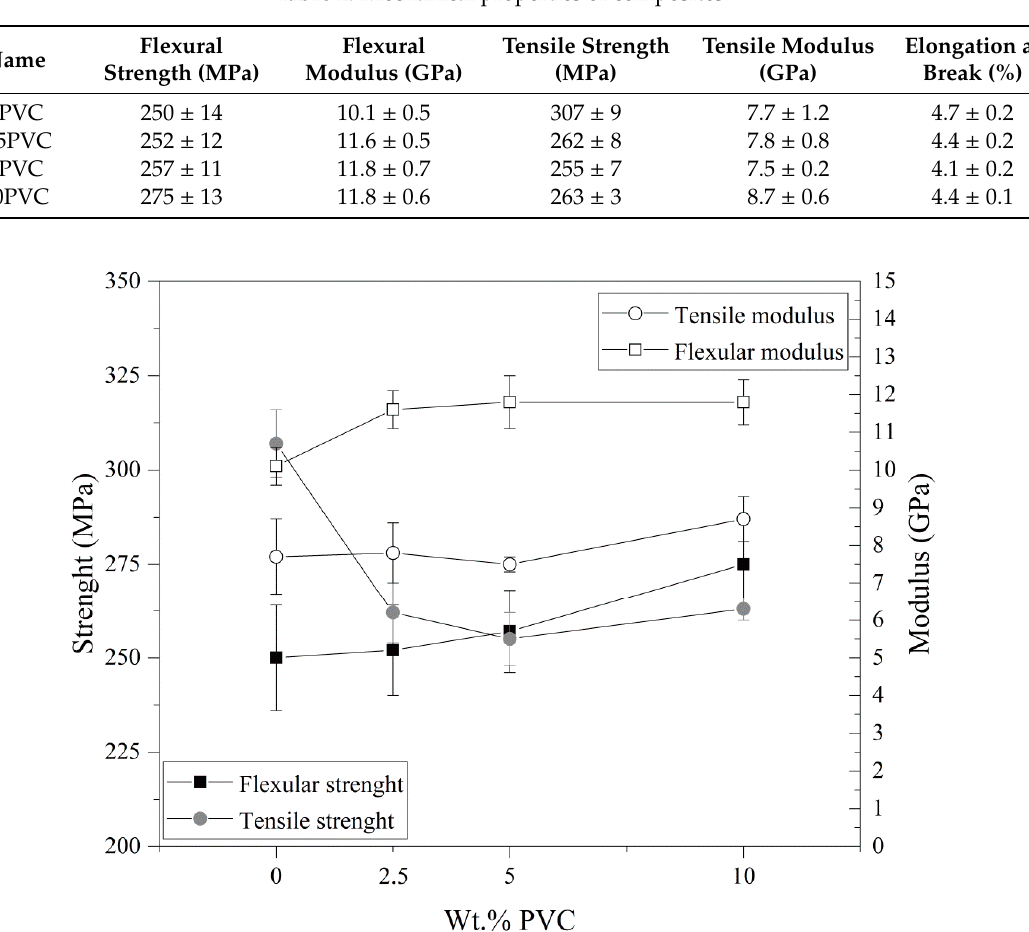
Table 2. Mechanical properties of composites.